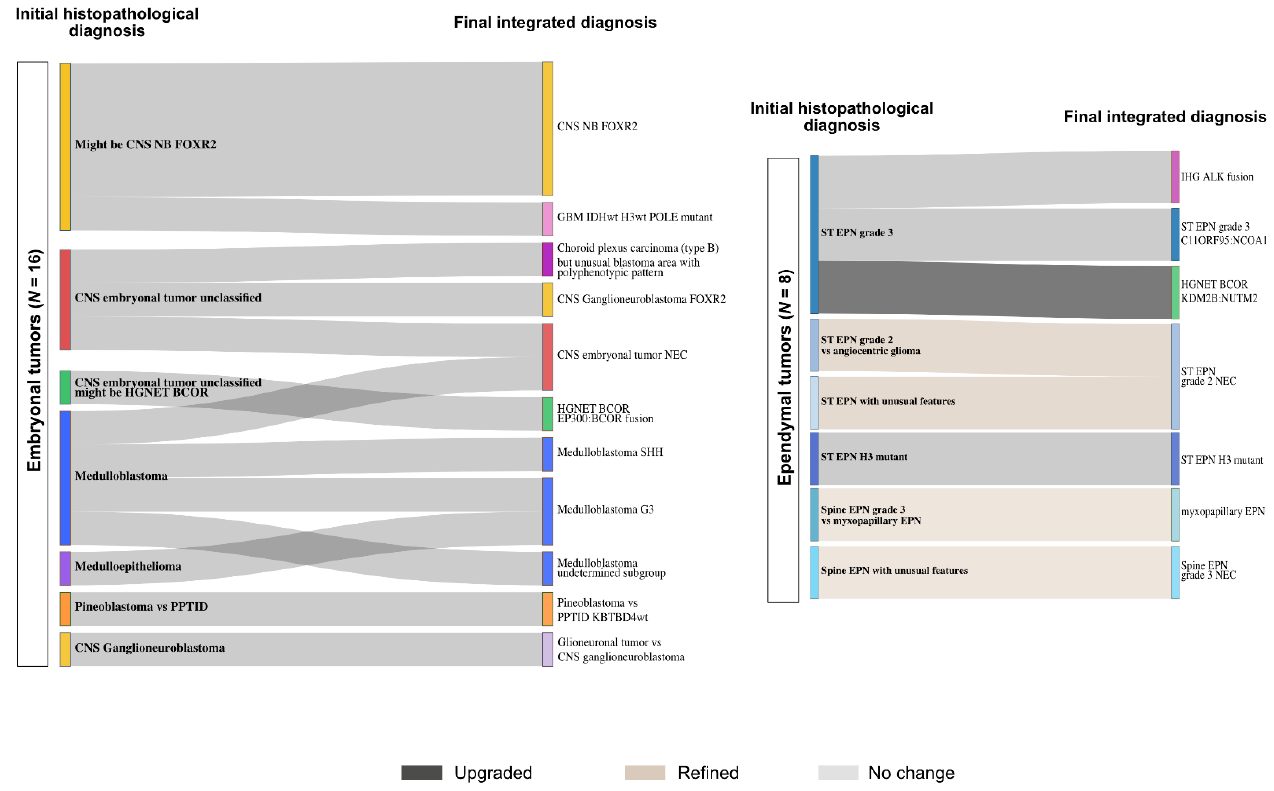
Figure 7. Establishing diagnoses in embryonal and ependymal tumors. The integration of data from DNA methylation array to the initial histopathological diagnosis (left) helped establishing final diagnoses (right) in embryonal tumors (left panel) and ependymal tumors (right panel). WHO grading changes are indicated in dark grey (upgrading), blue (downgrading) and light brown (refined). CNS NB FOXR2 = central nervous system neuroblastoma with FOXR2 activation, GBM = glioblastoma, HGNET-BCOR = high-grade neuroepithelial tumor with BCOR alteration, PPTID = pineal parenchymal tumor of intermediate differentiation, EPN = ependymoma, IHG = hemispheric infantile glioma, NEC = not elsewhere classified.